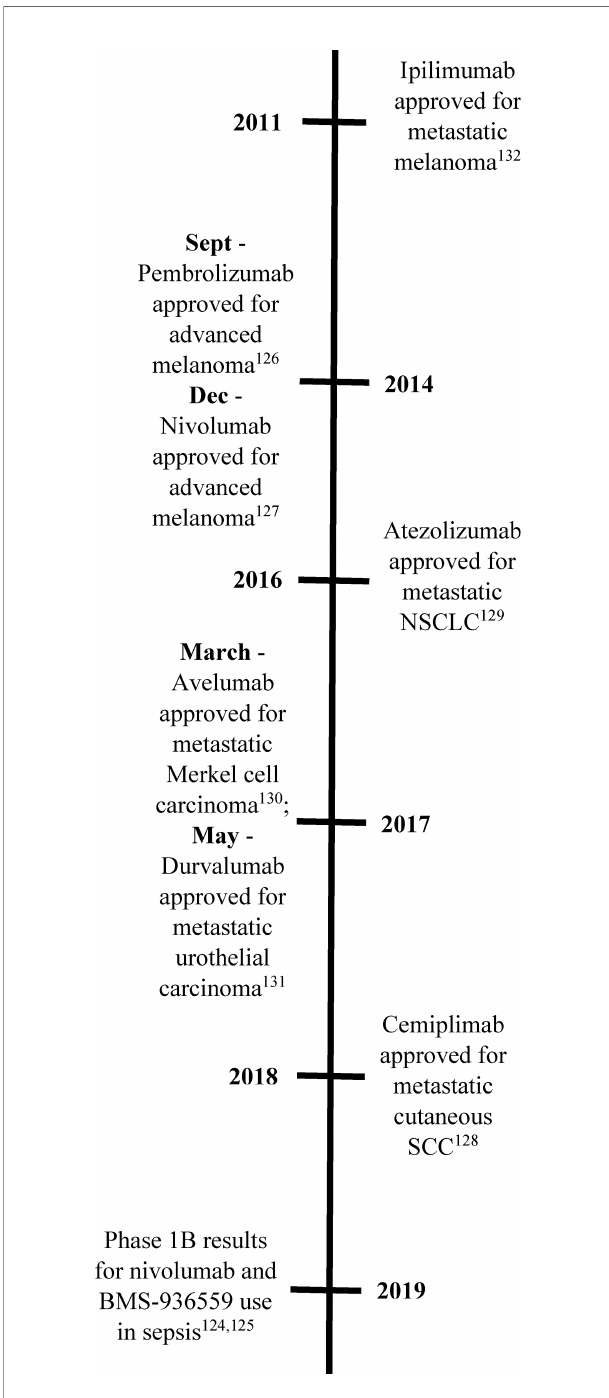
FIGURE 2 | Timeline of therapeutic applications of checkpoint inhibitor proteins. This timeline includes the initial FDA approval for each of the approved medications targeting checkpoint inhibitor proteins (PD-1, PD-L1, and CTLA-4), as well as the publications of phase 1 clinical trial results for two of these medications in septic